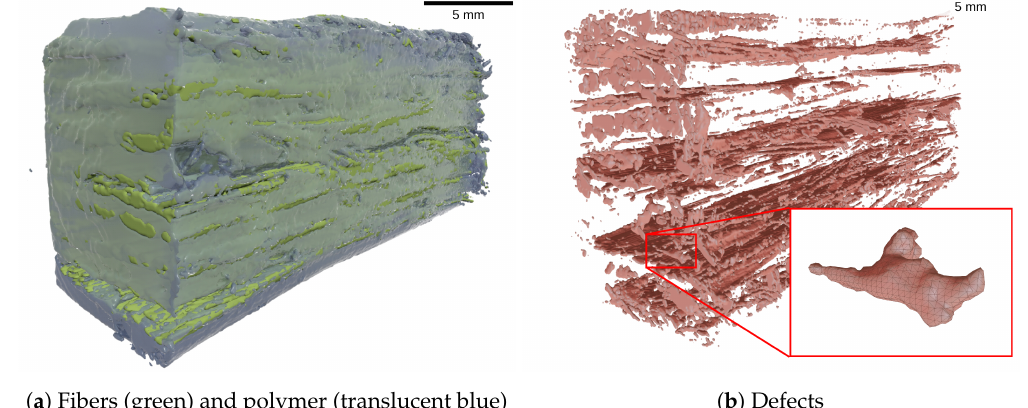
Figure 3. 3D reconstruction of phase geometry for specimen a6: ( a ) fibers and polymer; ( b ) defect phase only. A detail of the reconstructed 3D surface mesh is also shown here. (For references to color, please refer to the on-line version of this